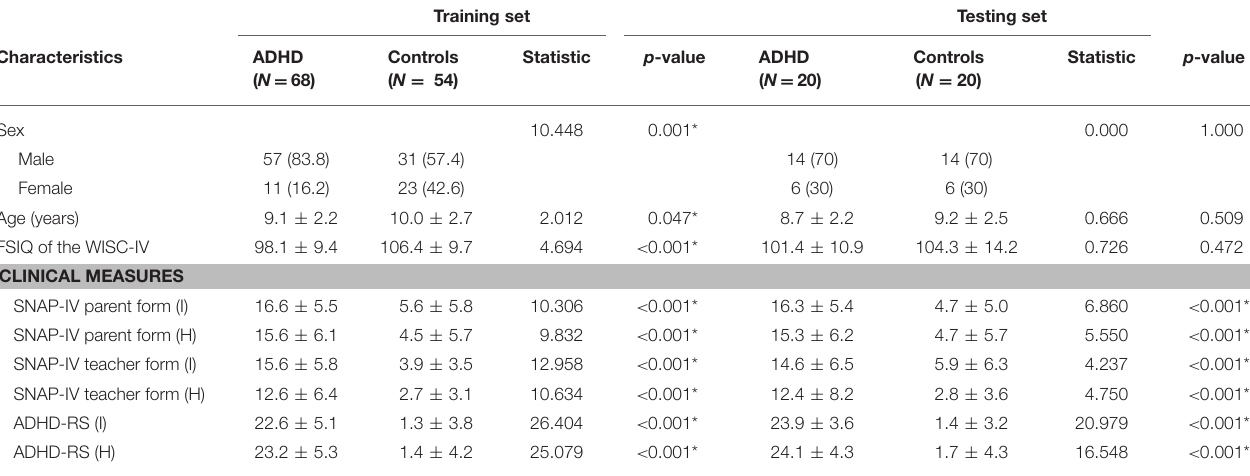
TABLE 1 | Characteristics of patients with ADHD and healthy controls in the Training Set and the Testing Set. Training set Testing set Characteristics ADHD Controls ( N = 68) ( N =